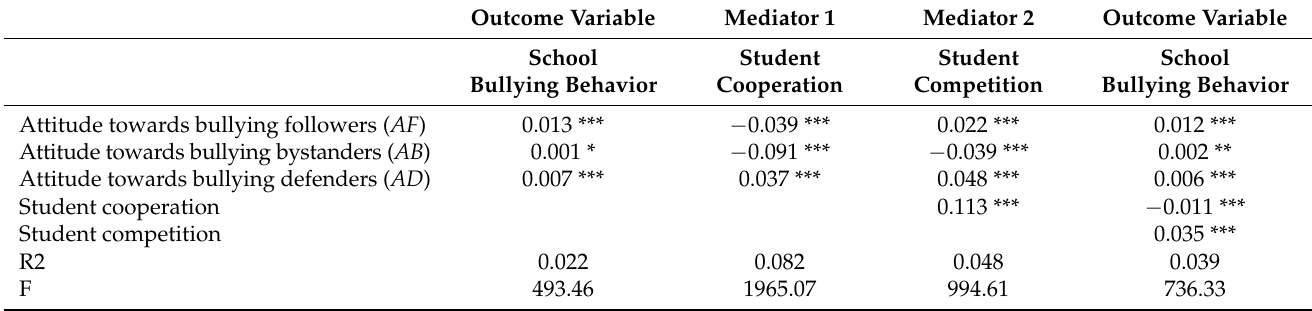
Table 5. Mediating effects of student cooperation and competition.